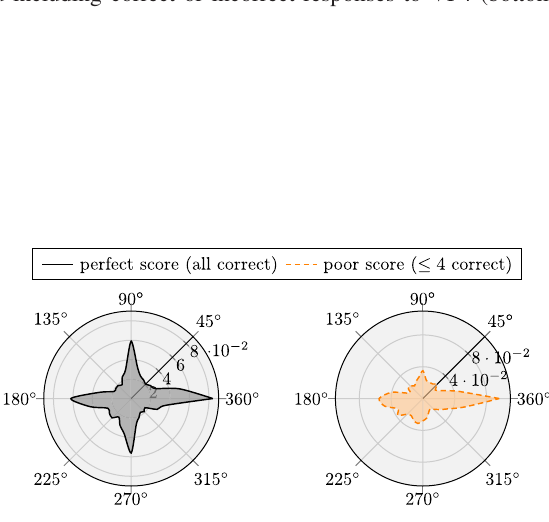
FIG. 7. Polar distributions of saccadic angles for experts and novice students including data from all divergence items (top), and including correct or incorrect responses to VF4 (bottom).